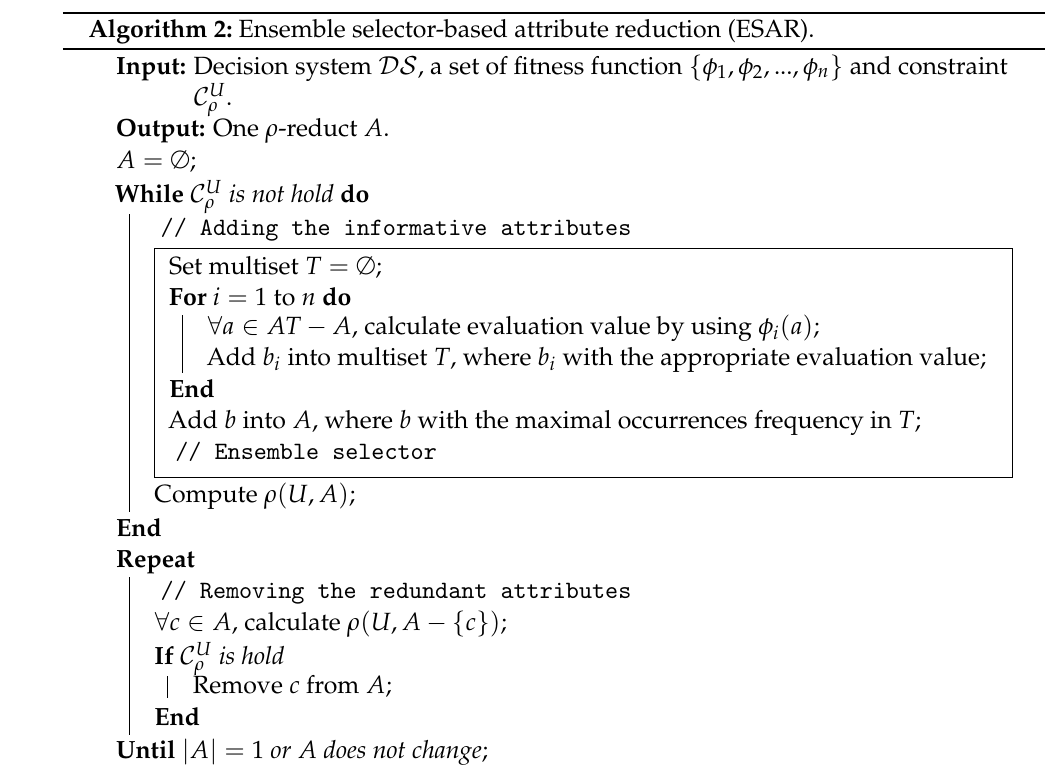
Algorithm 2: Ensemble selector-based attribute reduction